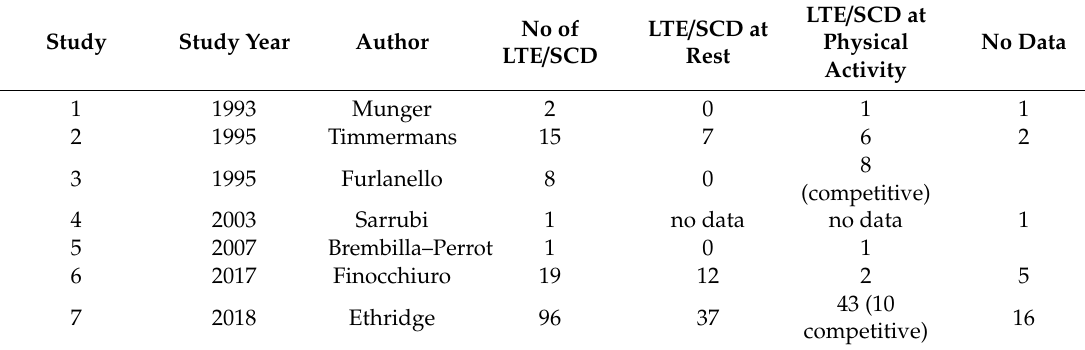
Table 2. Studies that revealed relation of life-threatening events (LTE) / sudden death (SCD) to physical activity are shown